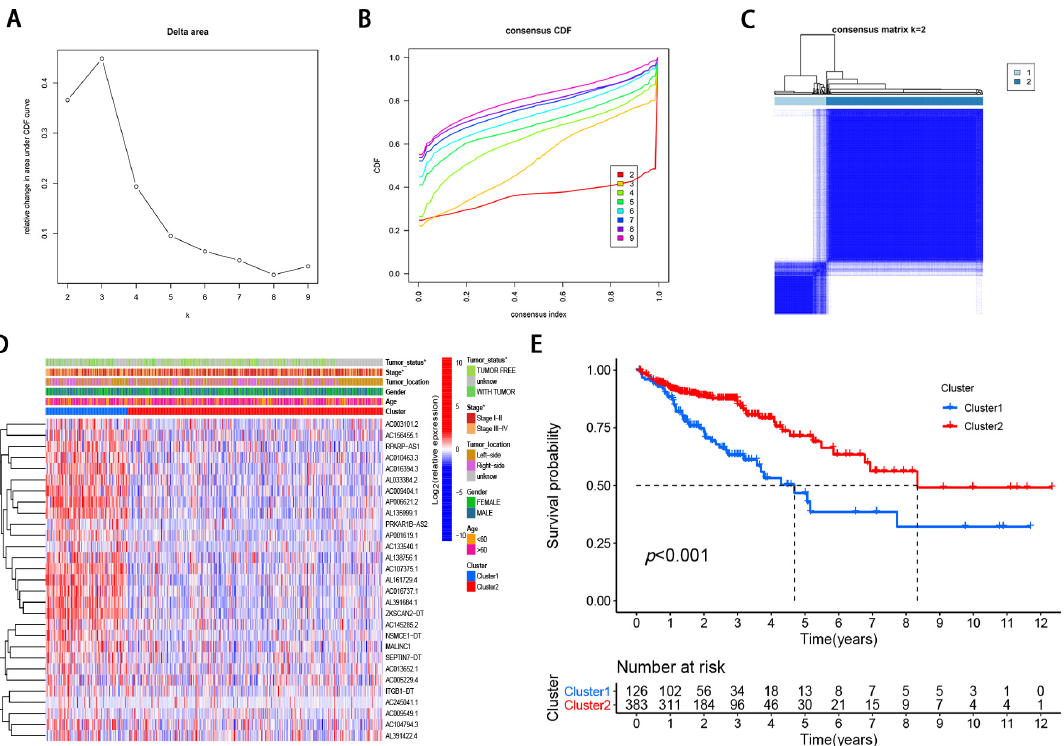
Figure 2. Differential clinicopathological features and survival of CRC in two cluster subtypes. ( A ) Consensus clustering cumulative distribution function (CDF) for k = 2 to 9. ( B ) Relative change in area under CDF curve for k = 2–9. ( C ) Consensus clustering matrix for k = 2. ( D ) Heatmap of correlation of the two clusters with clinicopathologic features. ( E ) Kaplan–Meier curves of overall survival for patients with CRC in two